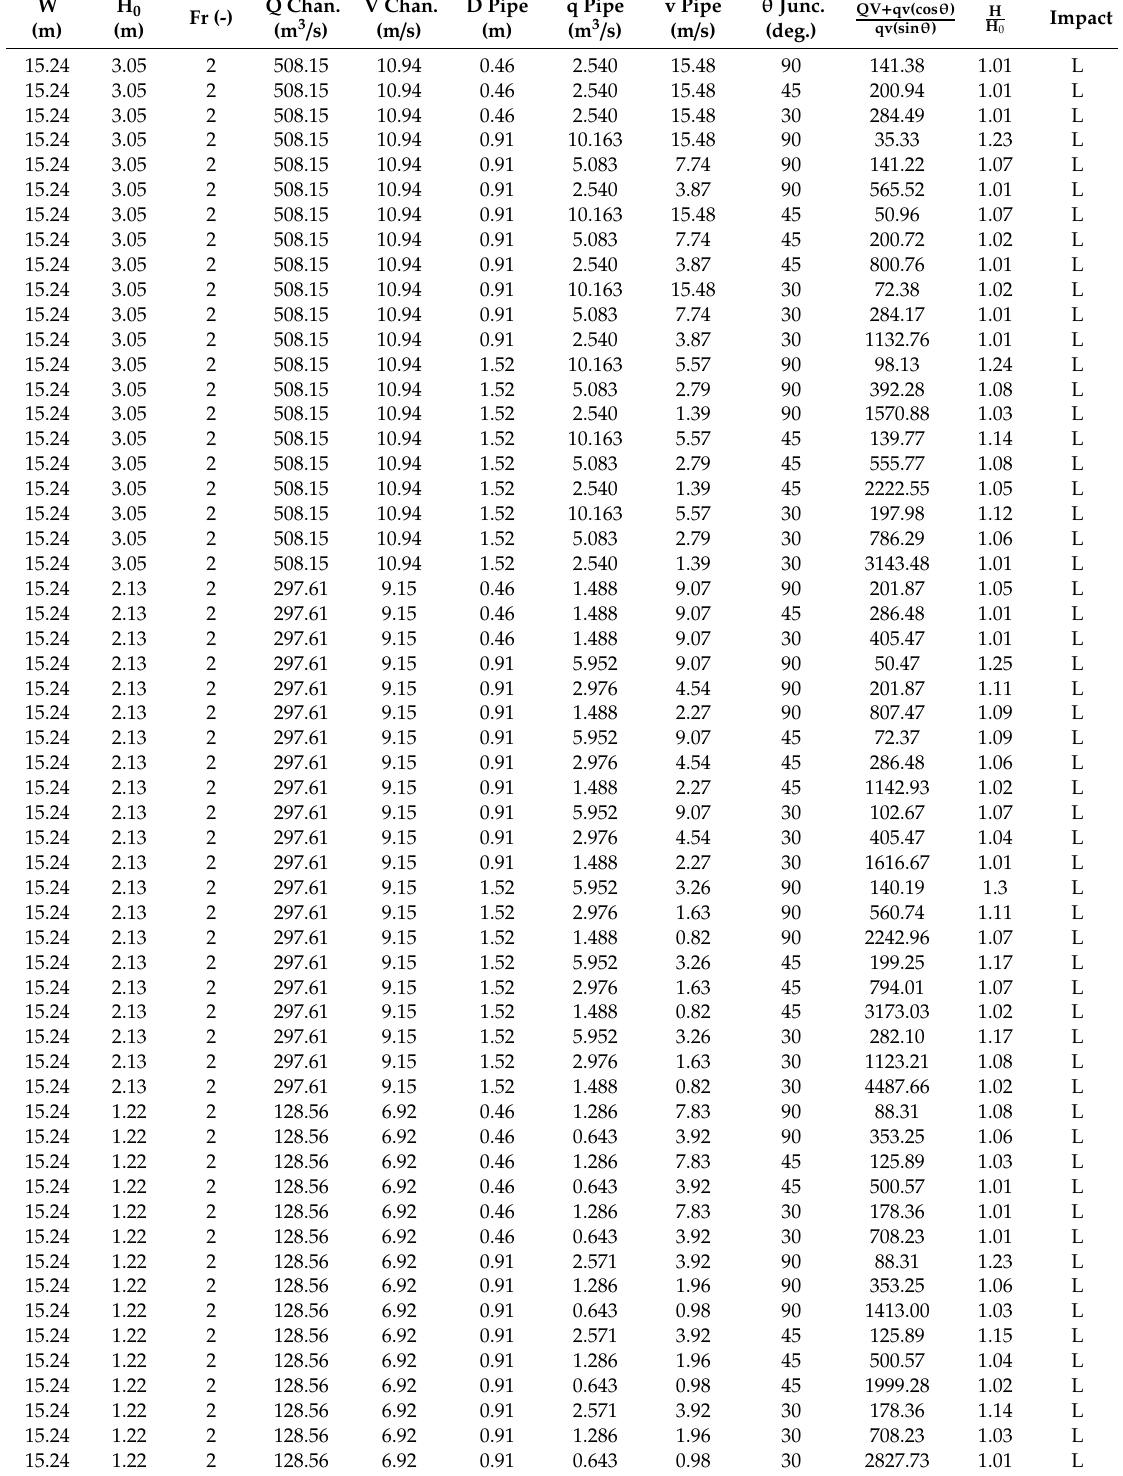
Table A3. FLOW-3D simulation results for W = 15.24 m (50 (cid:48) ) and Fr = 2. W